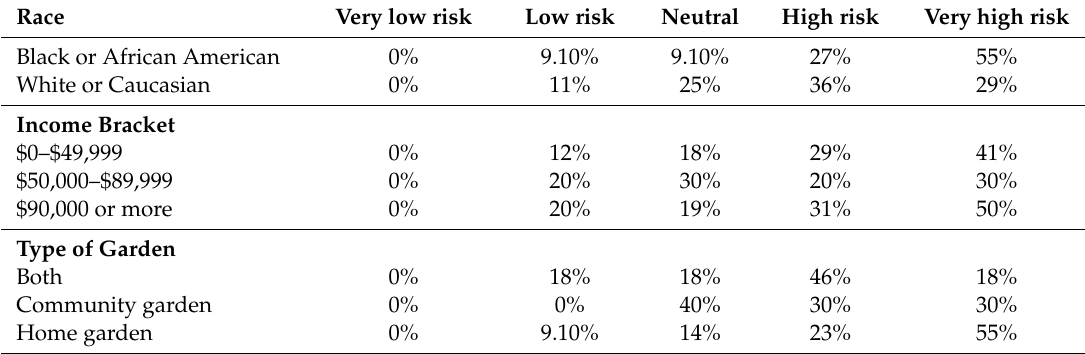
Table A10. Participants’ perceived risk of heavy metal soil contaminants on health.